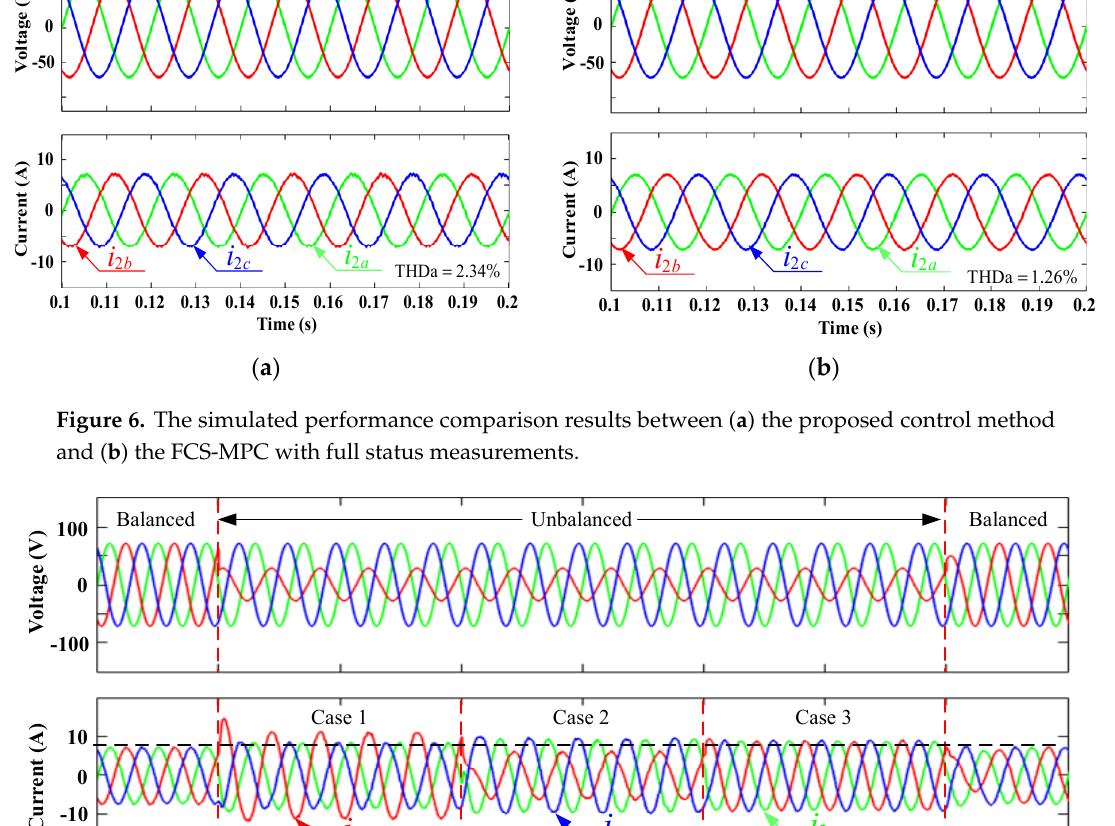
Figure 6. The simulated performance comparison results between ( a ) the proposed control method and ( b ) the FCS-MPC with full status measurements.